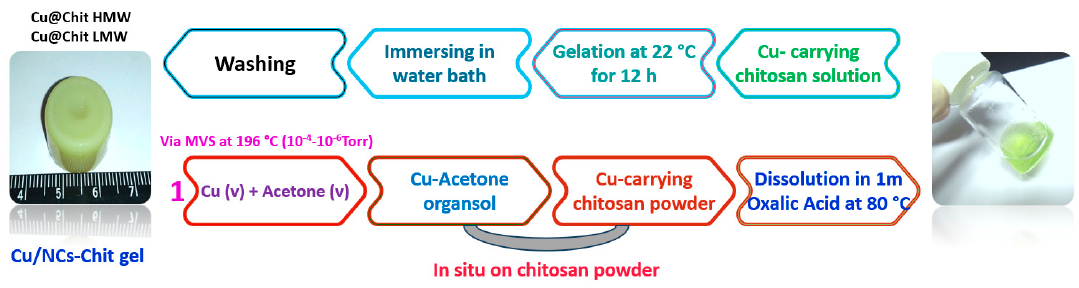
Figure 6. Scheme of preparation of chitosan hydrogels from Cu-carrying chitosan powders.